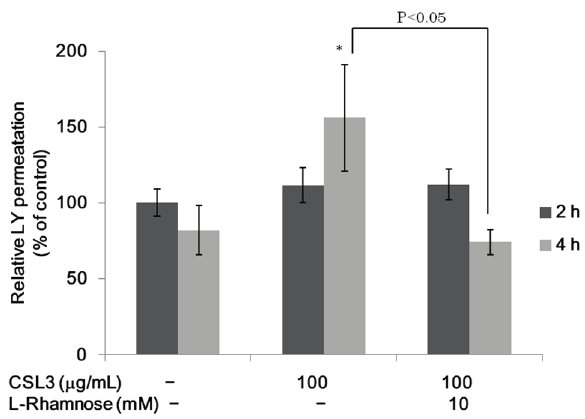
Figure 5. Effect of CSL3 on LY transport across Caco-2 cell monolayers. LY in the basolateral side was measured after incubating with CSL3 for 2–4 h. After incubation with CSL3 for 2 h, 10 mM L -rhamnose was added to the apical side. Results are shown as a percentage of the control (without lectins) value, and are the means ± SD of three different determinations. * p < 0.05 compared with the control value at 2